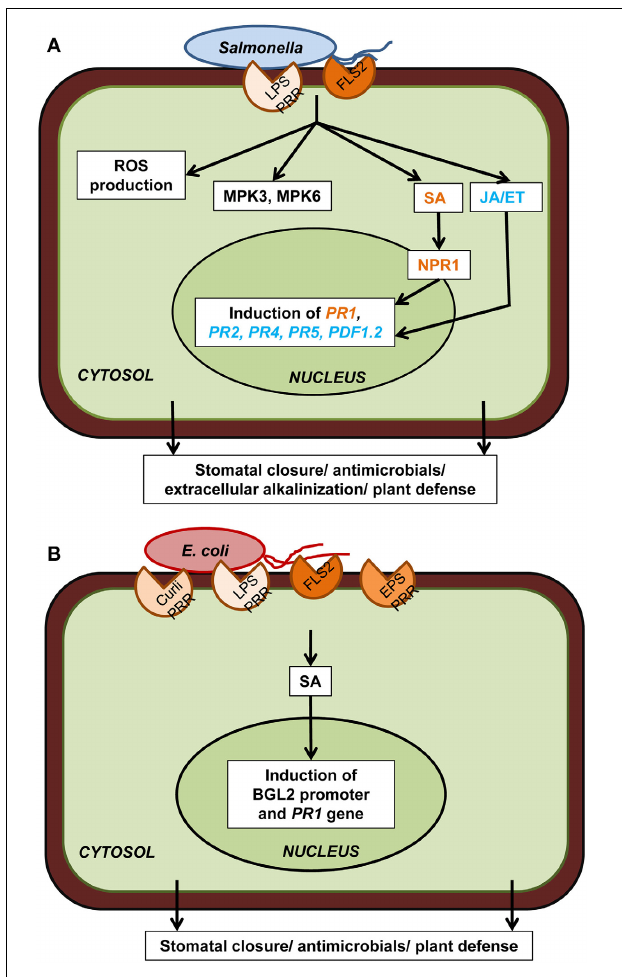
FIGURE 2 | Plant cellular defense responses against human pathogens. (A) Upon reception of PAMP (flagellin, LPS) through PRR (FLS2 and putatively others), Salmonella spp. trigger downstream plant defense responses which include ROS production, MPK3/6, salicylic acid (SA) signaling through NPR1, jasmonic acid (JA) and ethylene (ET) signaling, defense-associated gene induction, and extracellular alkalinization. All these cellular events ultimately lead to stomatal closure, antimicrobial activity, and plant defense. (B) Escherichia coli PAMPs (curli, LPS, flagellin, EPS) are also perceived by PRRs (FLS2 and putatively others) present on plant cell surface which triggers the induction of the SA-dependent BGL2 promoter activity and PR1 gene expression. Only components that have been directly demonstrated experimentally are included in the diagram. Plant defense responses in case of both these human pathogens are strain specific as well as plant cultivar